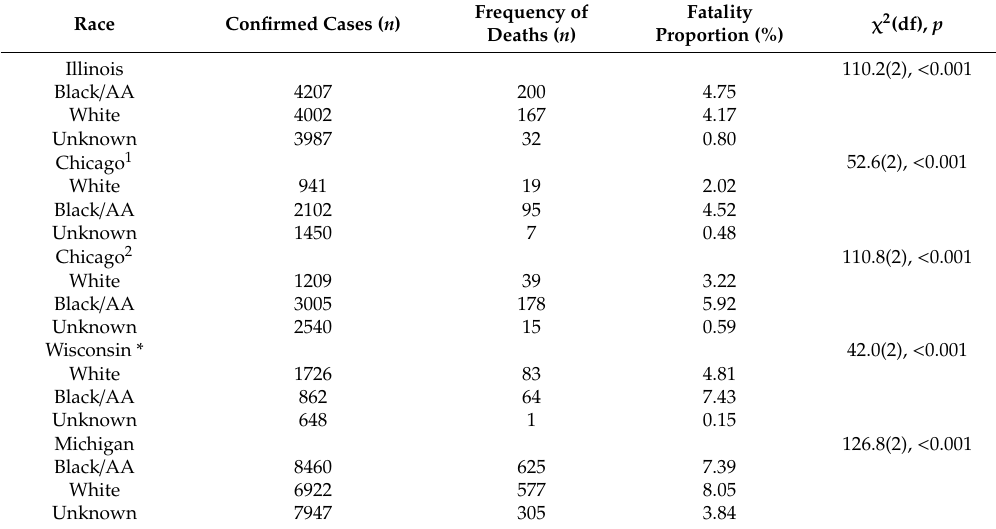
Table 2. COVID-19 case fatality in Illinois, Chicago, Wisconsin by race, the 9th through to the